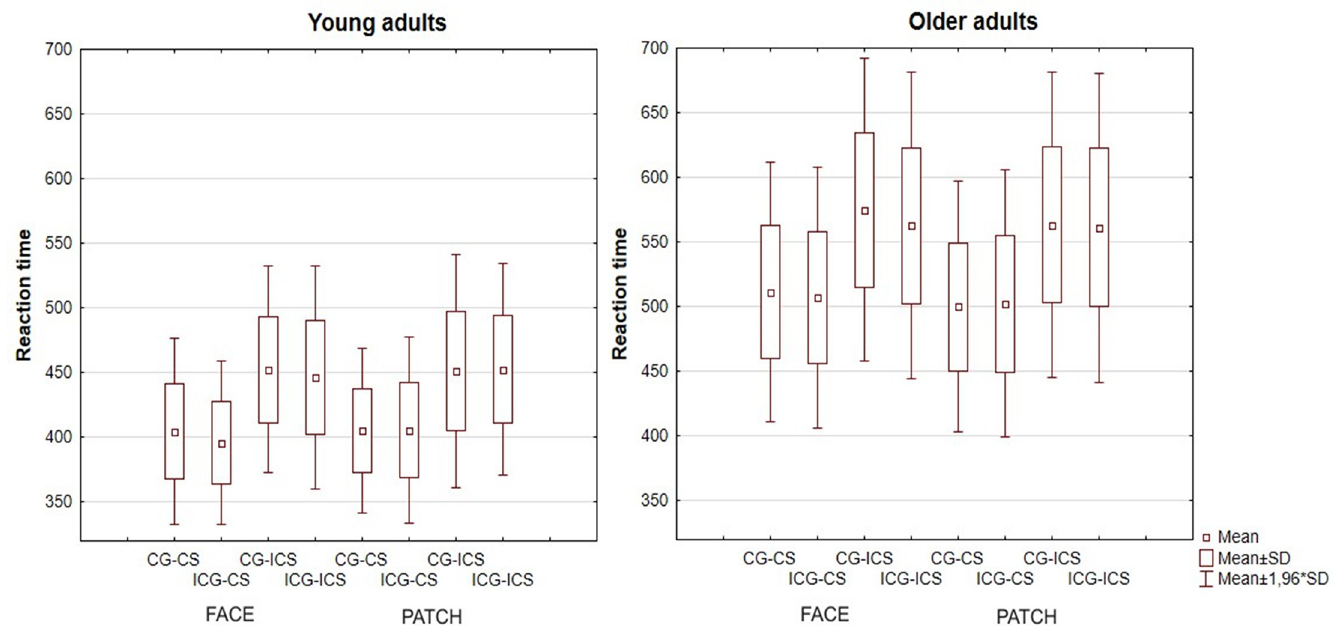
Fig 4. Reaction time data (mean and standard deviation) of young and older adults for face and patch cues in congruent gaze-congruent simon (CG-CS), incongruent gaze-congruent simon (ICG-CS), congruent gaze-incongruent simon (CG-ICS), and incongruent gaze-incongruent simon (ICG-ICS) conditions.